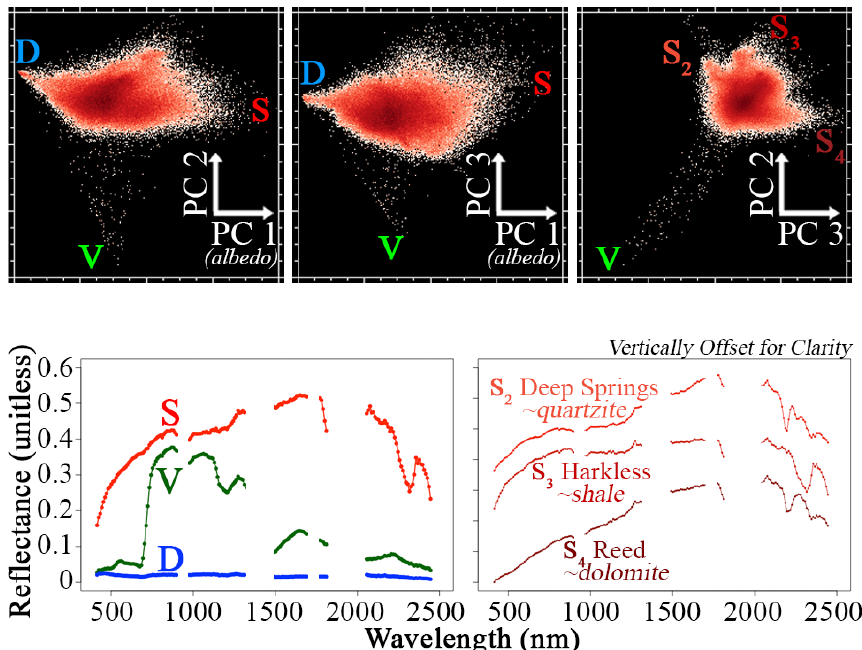
Figure 3. Spectral feature space of the study area ( top ) and example local endmembers ( bottom ). Substrate, vegetation, and dark (S: red, V: green, D: blue) endmembers used for the three-endmember mixture model are shown in the lower left. As expected for a lithologically complex area, the set of plausible S endmember signatures contains substantial diversity (e.g., S2–S4, each hosting distinct mineral assemblages, lower right). To the generic mixture model, this variability manifests as an error—but to the mixture residual, it is treated as a signal.